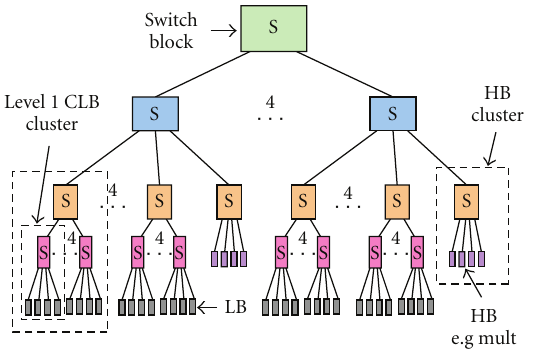
Figure 3: Tree-based heterogeneous FPGA